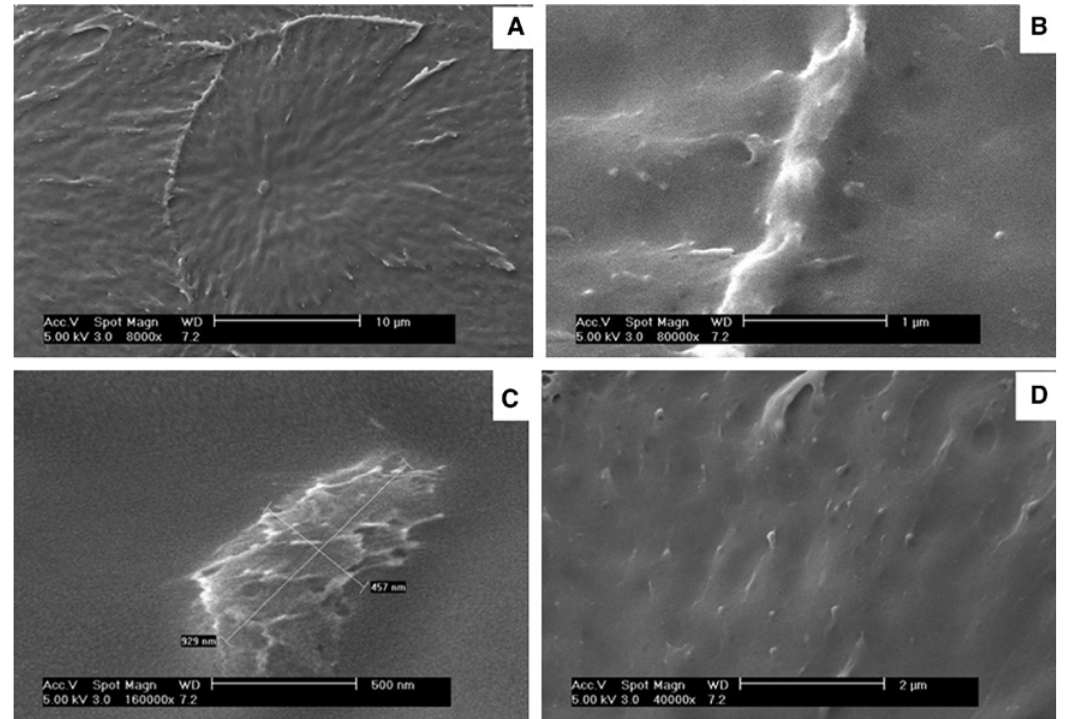
Figure 13: SEM microstructure of the single chip. (A) Whole Single chip, (B) Boundary, (C) Central particle (D) Surface of the single chip.